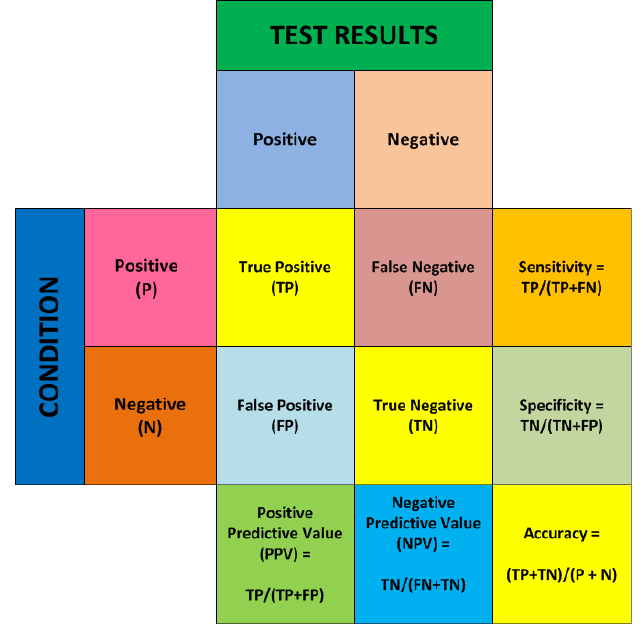
Figure 1. Confusion matrix—showing different measures of classification.